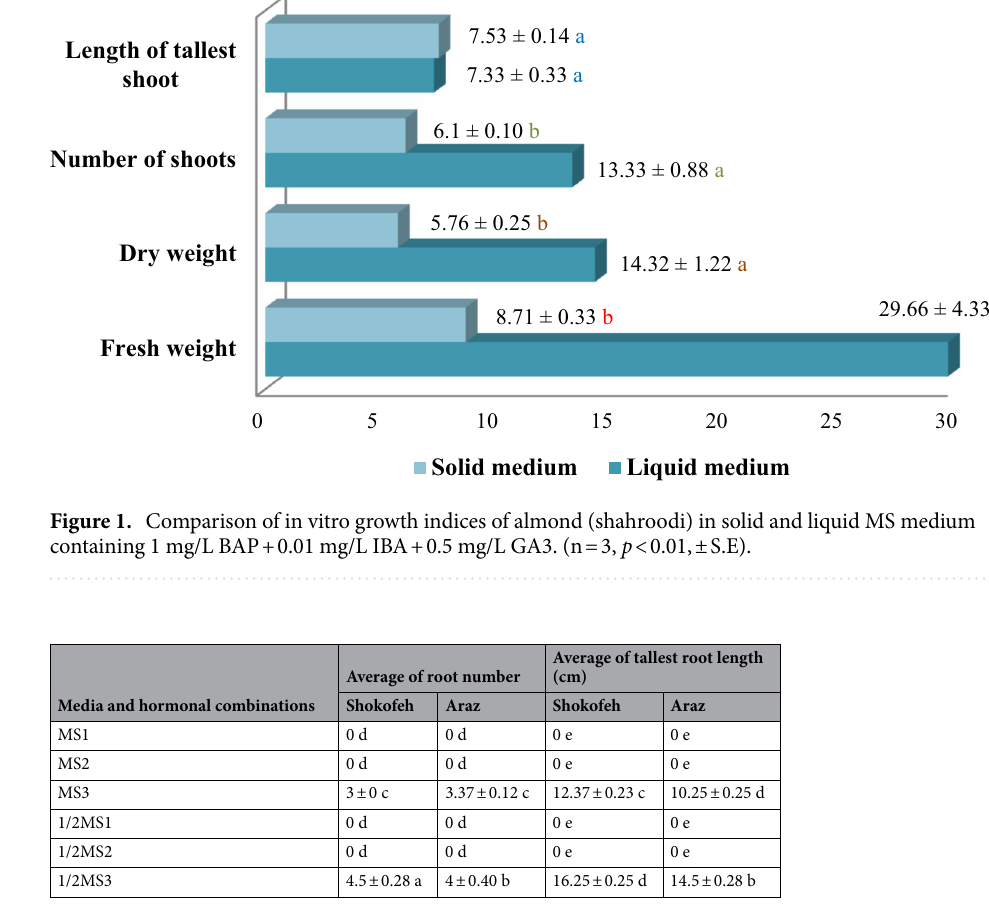
Table 4. Interaction effects of 2 cultivars × 2 media × 3 hormonal combinations on average of root number and average of tallest root length. The Figures 1, 2 and 3 on the side of each medium mean the hormonal combinations 1, 2 and 3; (1) Plant growth regulator free medium, (2) IAA (1 mg/L) and (3) IAA (1 mg/L) + IBA (0.5 mg/L). (n = 4, p < 0.01, ± S.E).